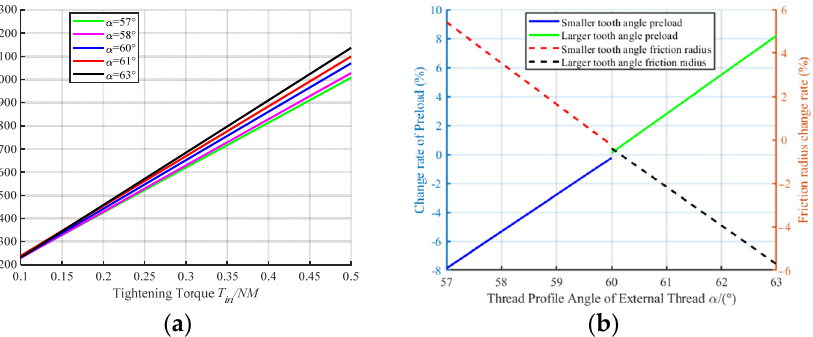
Figure 6. ( a ) Tightening curve under thread profile angle deviation, ( b ) change curve of equivalent